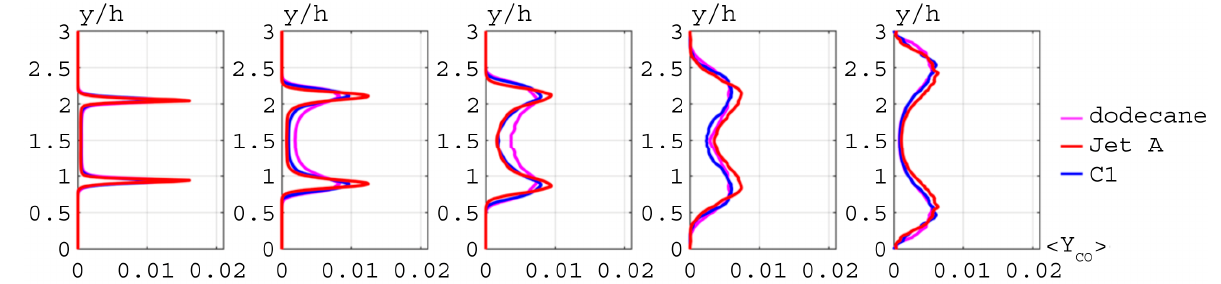
(cid:69) , at x/h = 0.375, 0.95, 1.53, 3.75,